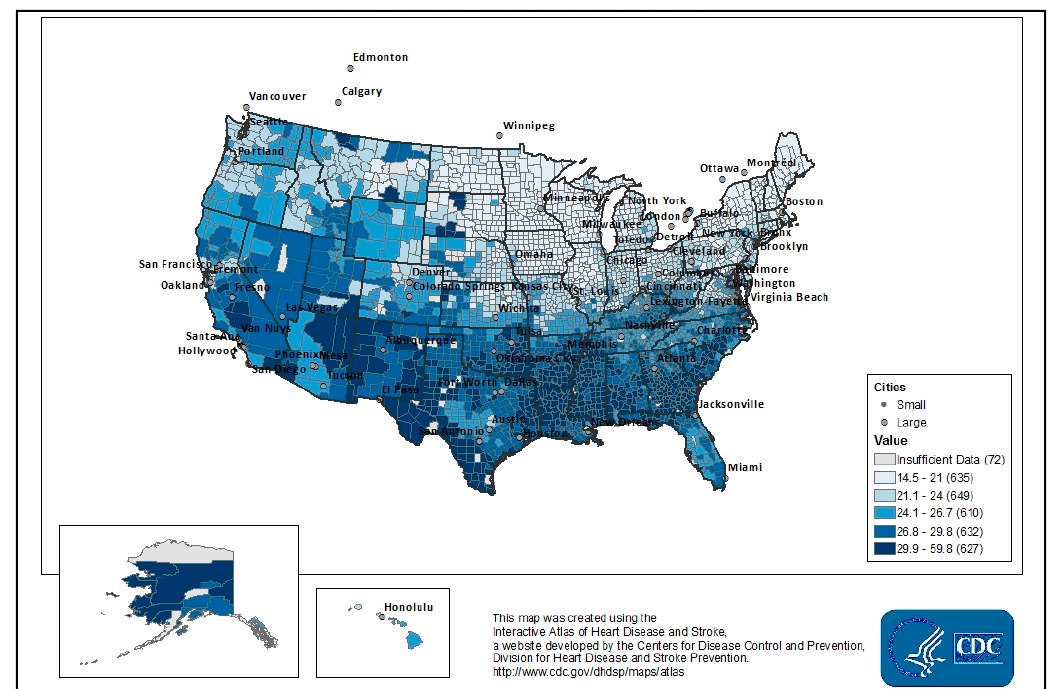
Figure 3. Geographic distribution of the prevalence of non-adherence to antihypertensive medications in the U.S., 2015. Table 1. Distribution of social determinants of health (SDH) indicators across geographical regions among counties in the U.S., 2015–2016.